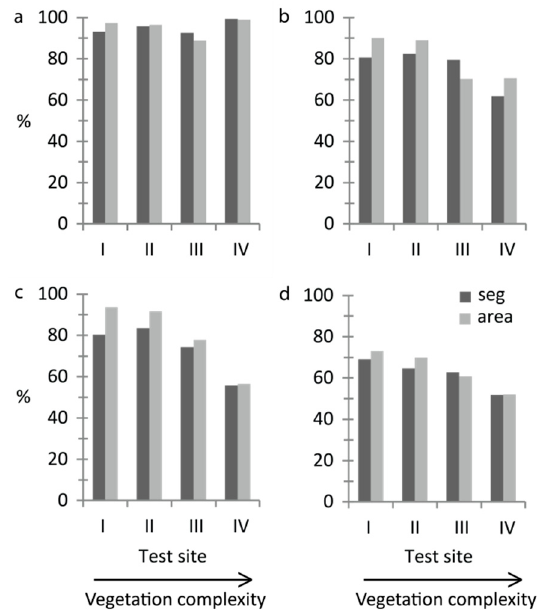
Figure 3. Overall accuracy for sites I–IV for ( a ) water-versus-vegetation classification using thresholding; ( b ) growth-form classification using thresholding; ( c ) growth-form classification using Random Forest; and ( d ) dominant-taxon classification using Random Forest. Seg: assessment based on number of validation segments, area: assessment based on area of validation segments. Table 5. Producer’s and User’s accuracy (%) of water (W) versus vegetation (V) using a threshold classification.